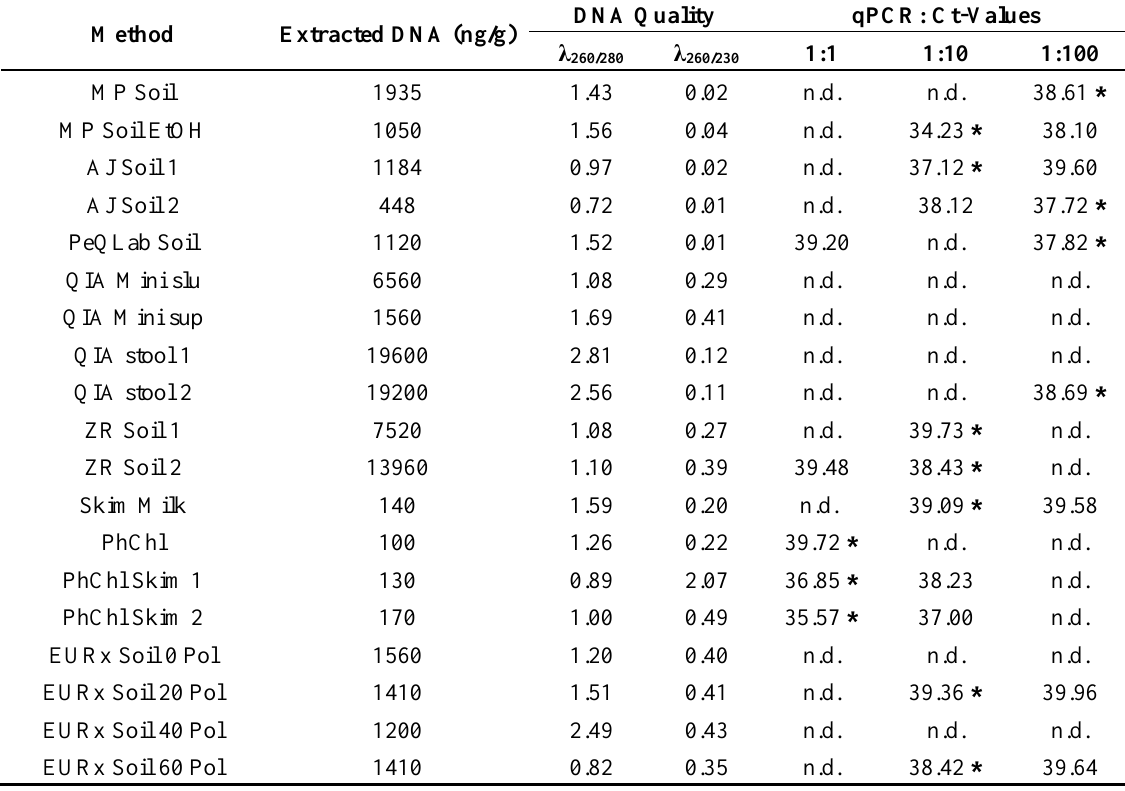
Table 2. Quality and amount of extracted DNA and Ct-values of